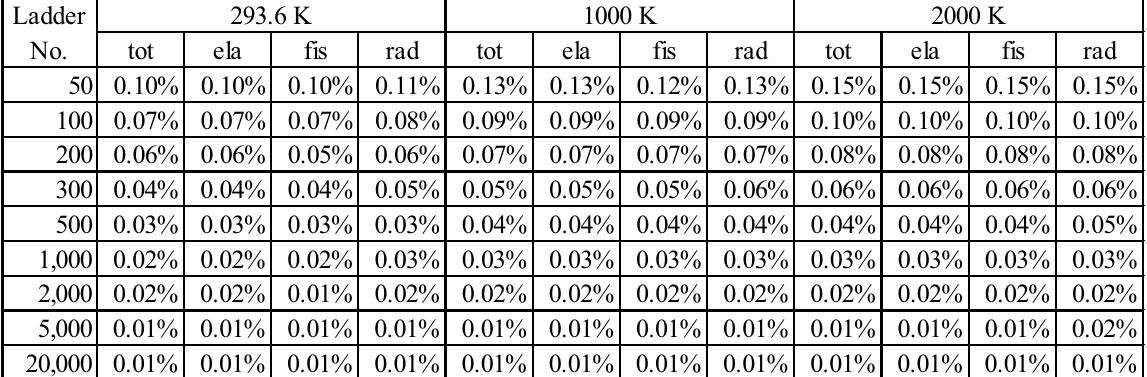
Table II. RMS value of probability table difference in each ladder number ( 238